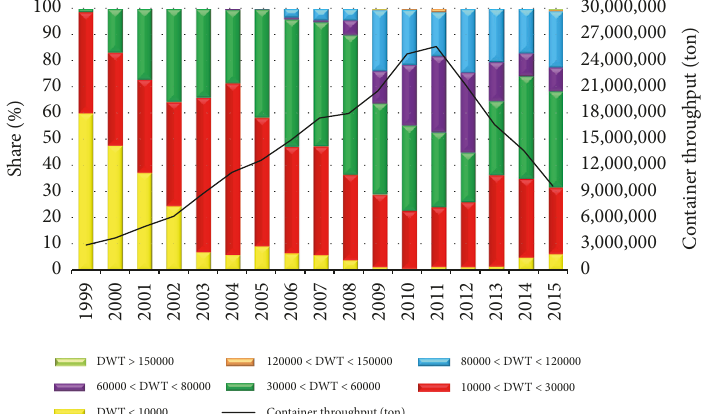
Figure 6: Share of container ships in cargo displacement during 1999 to 2015 and container throughput in the Shahid Rajaee port. Black line shows container throughput for each of the years. It can be seen that peak years of container throughput are 2008 to 2012.